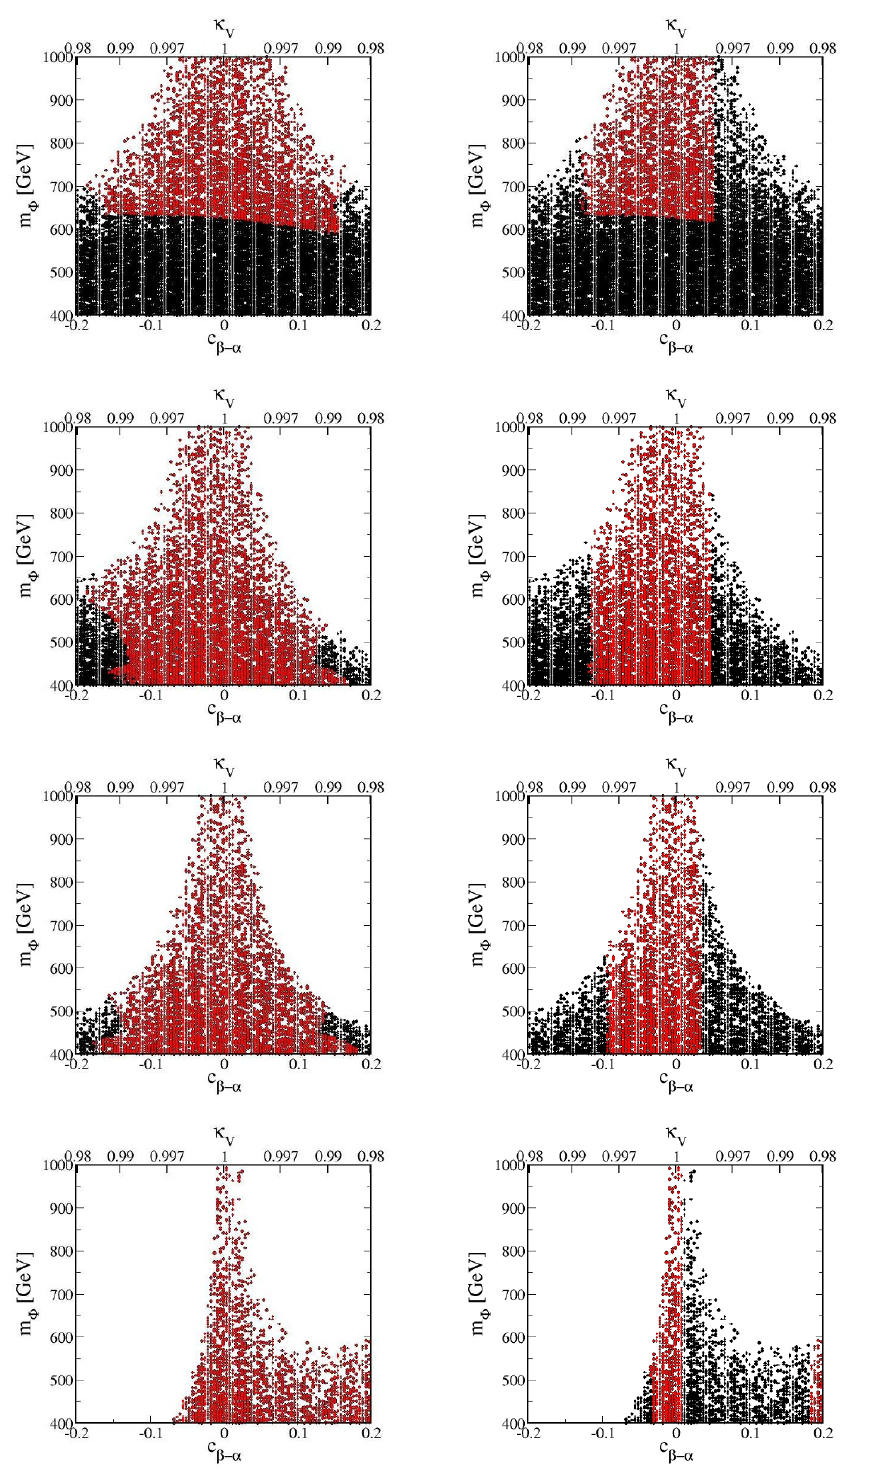
Figure 8 . Black (red) dots are allowed only by Bound A (by both Bound A and the LHC data) in the Type-I (left) and Type-II (right) 2HDMs. The value of tan β is taken to be 1, 2, 3 and 10 from the top to bottom panels. The value of M is scanned to be from 0 to m Φ (= m